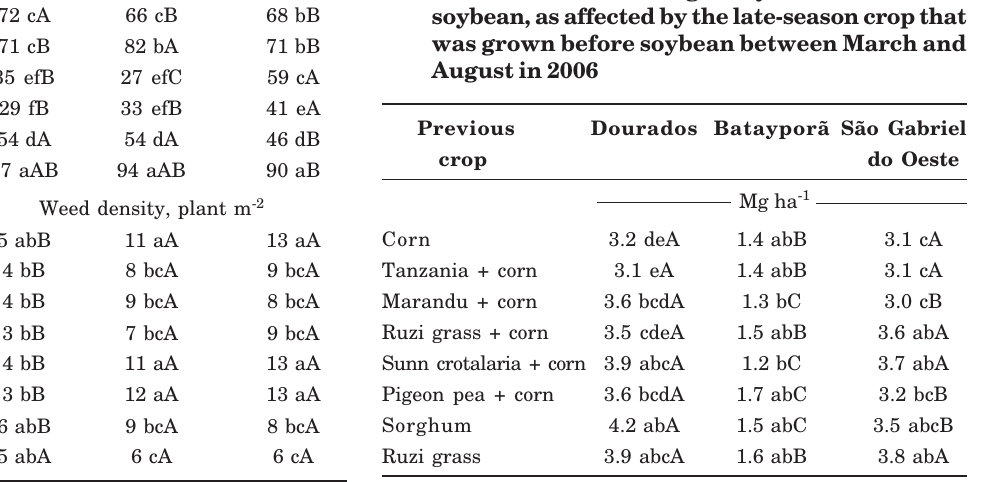
Means followed by the same lowercase letter in a column, and by the same uppercase letter in a row are not significantly different by the Tukey test (p